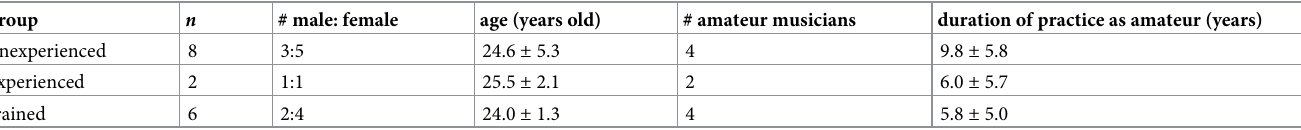
Table 1. Summary of participants’ information.